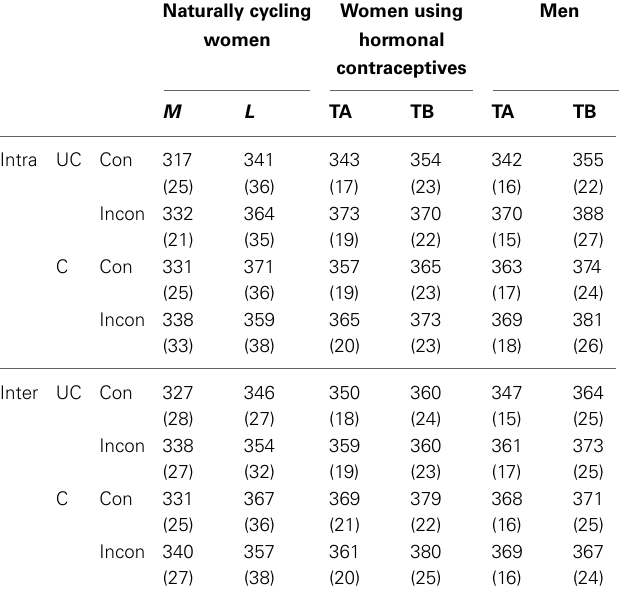
Table 4 | Average reaction times in ms (standard errors are shown in brackets) for congruent (Con) and incongruent (Incon) trials, differentiated by hemispheric projection (Intra: intrahemispheric; Inter: interhemispheric) and hand posture (UC: uncrossed; C: crossed).